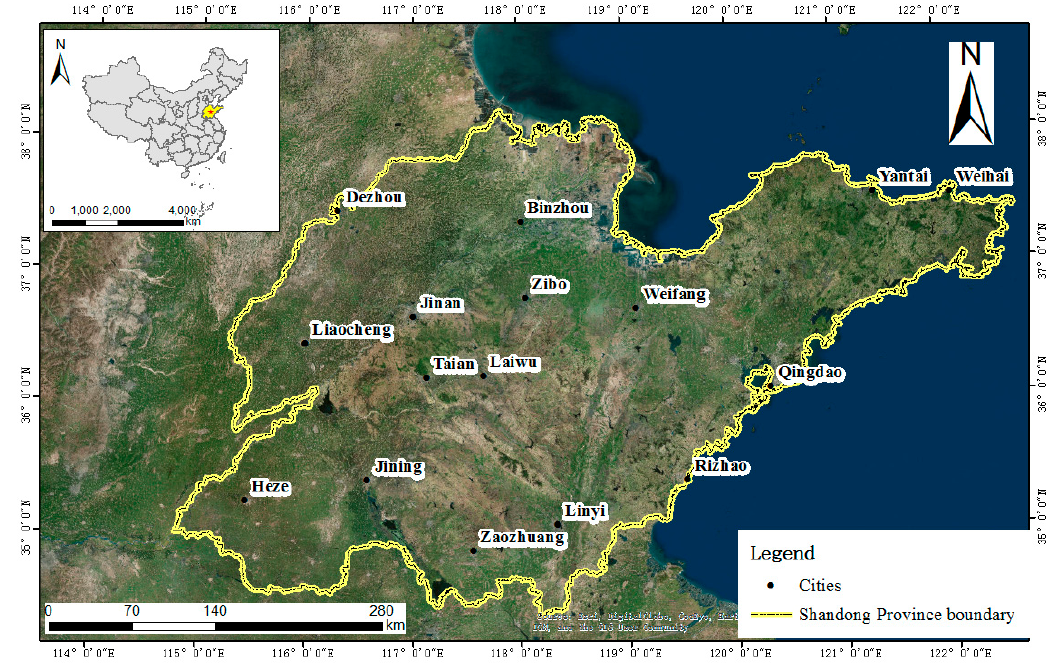
Figure 1. Study area and its location in China.